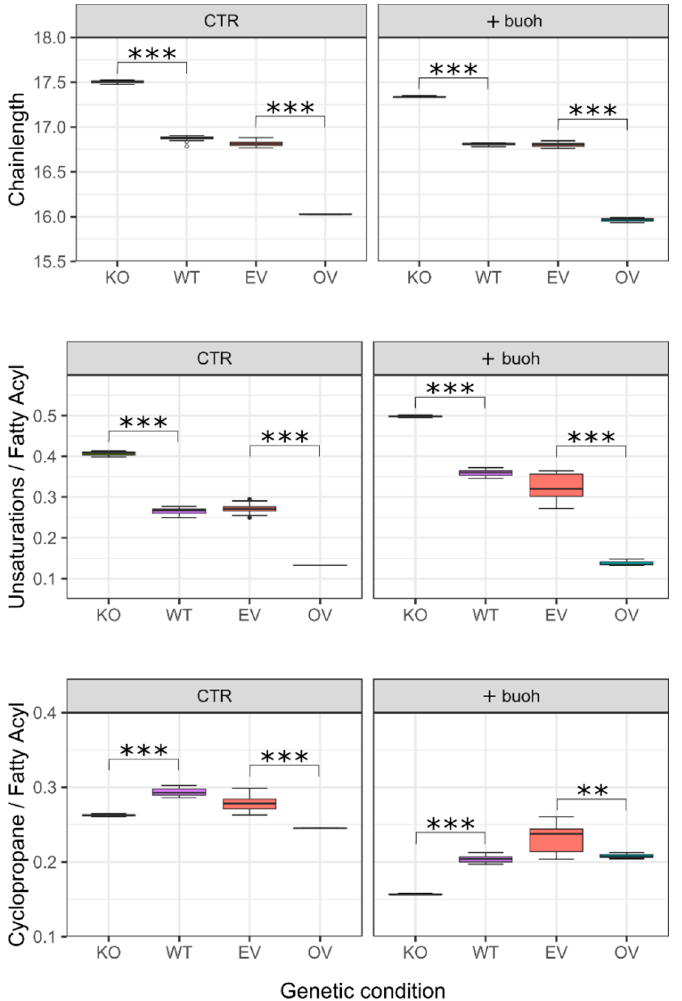
Figure 5. Boxplots demonstrating the effect of alteration of FabH levels on key properties of mem- brane lipids. KO and OV represent gene knock-out and overexpression, respectively. EV represents the wild-type (WT) transformed with an empty overexpression vector. Panels on the right (+buoh) were obtained from cells grown under identical conditions as the control (CTR) but in the presence of 0.5% ( v / v ) n -butanol. It should be noted that acyl properties were calculated from the data in supplementary Table S1 and that the values at y-axis should not be treated as absolute. A discrepancy may result from the fact that differences in ionization efficiency can exist between molecular species. Differences between the two control conditions (wild type WT and empty vector EV) were non- significant in all experiments shown. Statistical significances (based on uncorrected p -values) of KO and OV are shown with respect to their controls (WT and EV, respectively). **: p < 0.01; ***: p < 0.001. The degree of unsaturation of lipid acyl chains was affected in a similar way as the chainlength. The average number of unsaturations per fatty acyl chain dropped from 0.41 in the KO to 0.27 in the combined WT and EV samples ( p < 5 × 10 − 5 ), and again signifi- cantly further to 0.13 in the OV samples ( p < 2 × 10 − 16 ). Hence, the FabH overexpressor